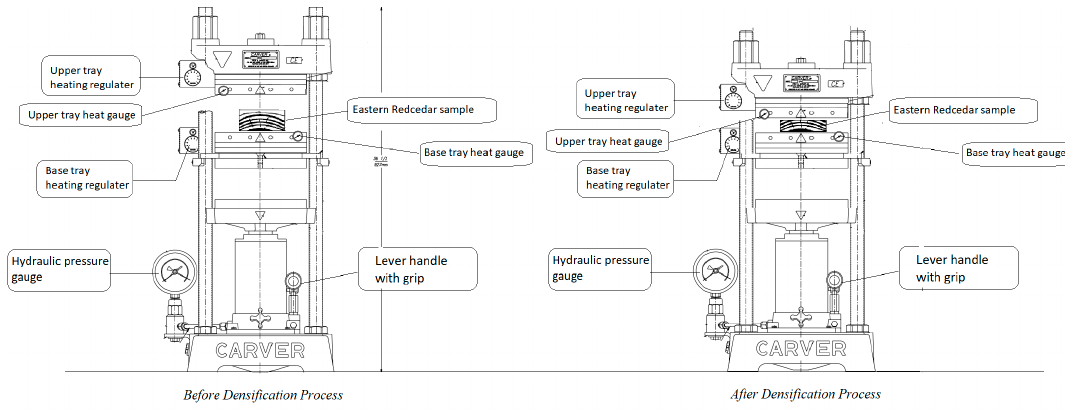
Figure 3. Densification process of the samples in Carver laboratory press.